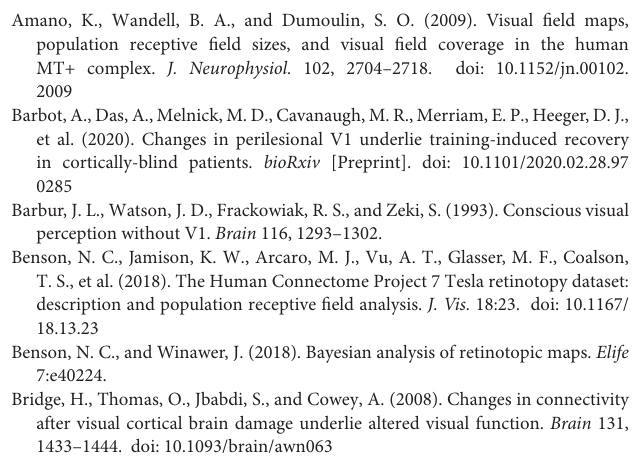
Supplementary Figure 1 | Population receptive field (pRF)-based eccentricity maps. Two visualizations of how output of the pRF mapping technique can be translated to eccentricity maps. The x and y Cartesian coordinates of the best pRF for each individual voxel were converted into polar coordinates, i.e., polar angle and eccentricity values. Here we projected the eccentricity values on an inflated hemisphere mesh. The upper two images display the eccentricity map for the left hemisphere of a control participant from a medial (left) and lateral (right) view. Similarly, the lower two images display the eccentricity maps for the left and lesioned hemisphere of a hemianopia patient. The case of the patient shows that also in the lesioned hemisphere we find cortical activity that partially represents the patient’s VF. The black outline corresponds to our visual cortex ROI, to which we limited our modeling computations. Projections have been thresholded for a variance explained of 15%. Supplementary Figure 2 | Extraction of MP derived pRF parameters. Left: initial probe map. Right: Thresholded probe map selecting the 30% probed with the highest VE ( k -threshold). The remaining probes were clustered using a weighted cluster analysis. Finally, the pRF parameters of the resulting cluster, here four, were derived using a Gaussian mixture model. The derived parameters were x and y, for the pRF its center location, σ 1 and σ 2 and θ (Gaussian orientation, angle between σ 1 and the x axis) allowing for an ellipsoidal Gaussian. Dashed blue circle outlines the pRF derived from the conventional pRF model, and the dashed red circle outlines the pRF derived from MP. For a more detailed description on this parameter extraction methods, see Carvalho et al.